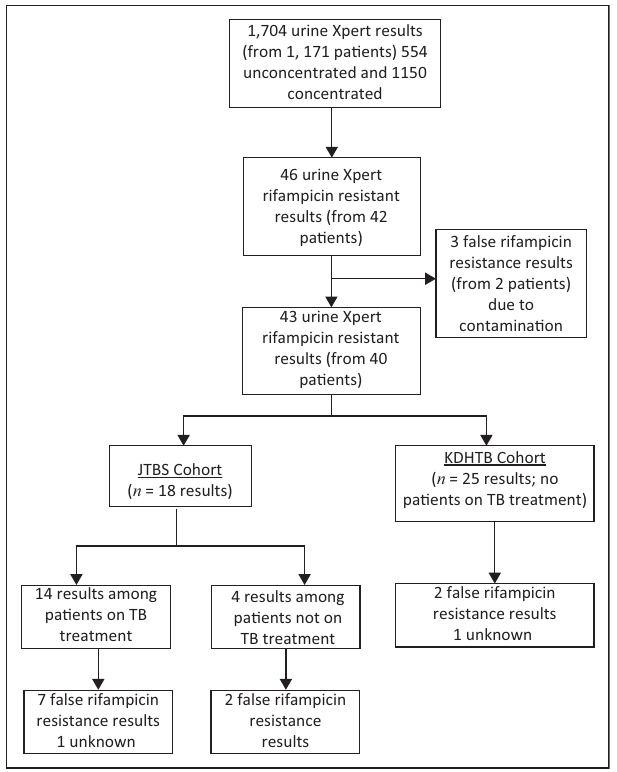
FIG URE 2: Urine Xpert rifampicin resistance results separated by cohort and tuberculosis treatment